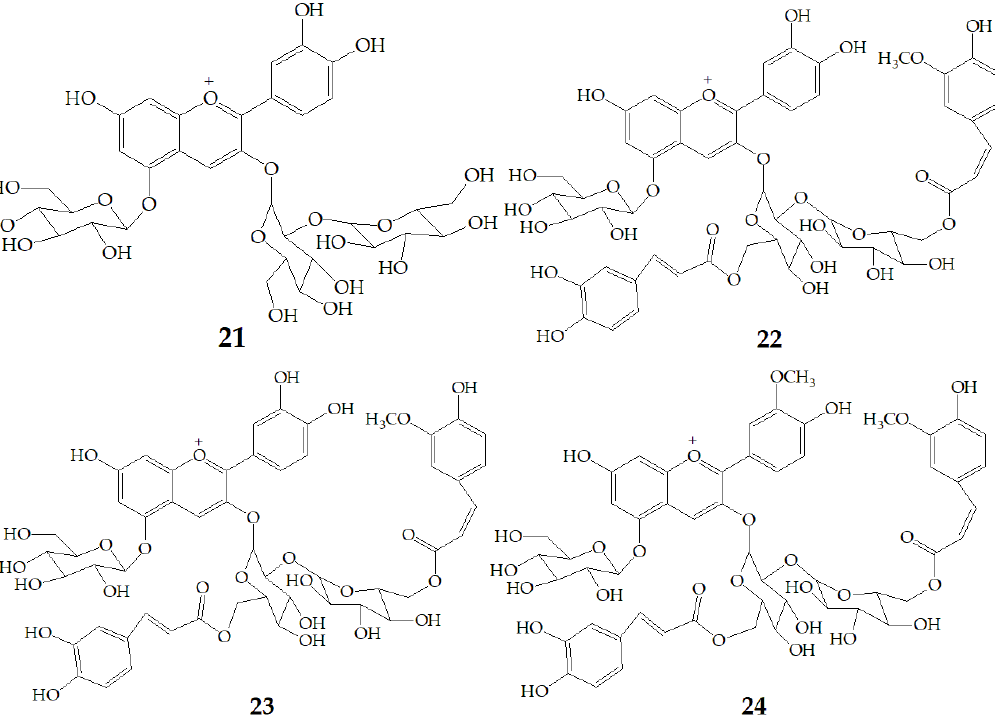
Figure 5. Chemical structures of compound 21 – 24 .